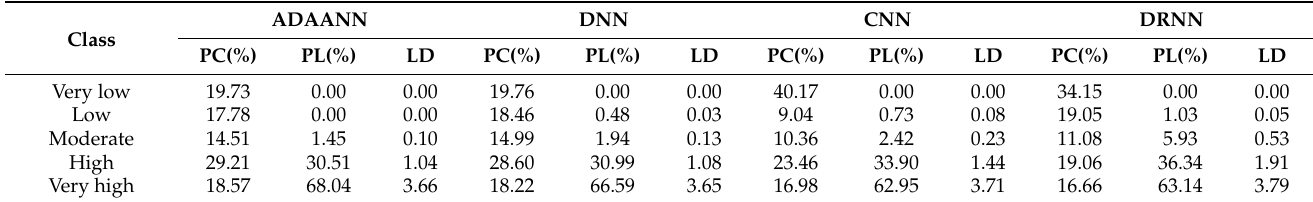
Table 2. Landslide density analysis on landslide susceptibility